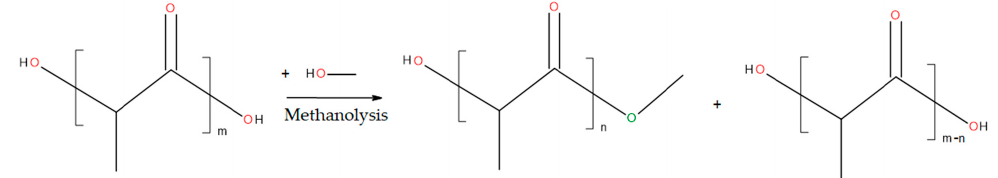
Figure 4. Proposed mechanism of the PLA methanolysis.